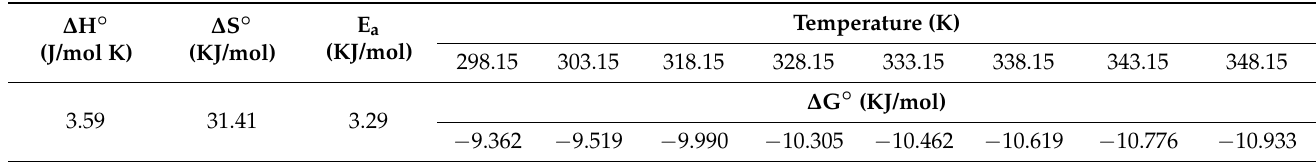
Figure 6. Study of the thermodynamics of heparin adsorption over QDASi using ( a ) LnK vs. 1/T, and ( b ) ln (1 − θ ) versus 1/T. Table 3. Calculated thermodynamic parameters for the heparin adsorption onto QDASi.